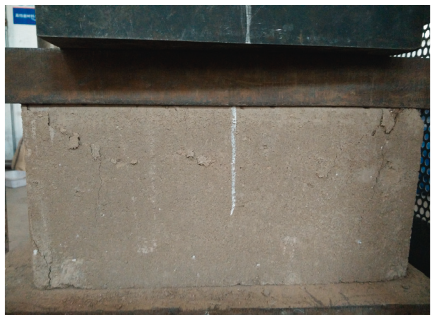
Figure 5: Typical failure mode of a single HCCSEB tested under compression.